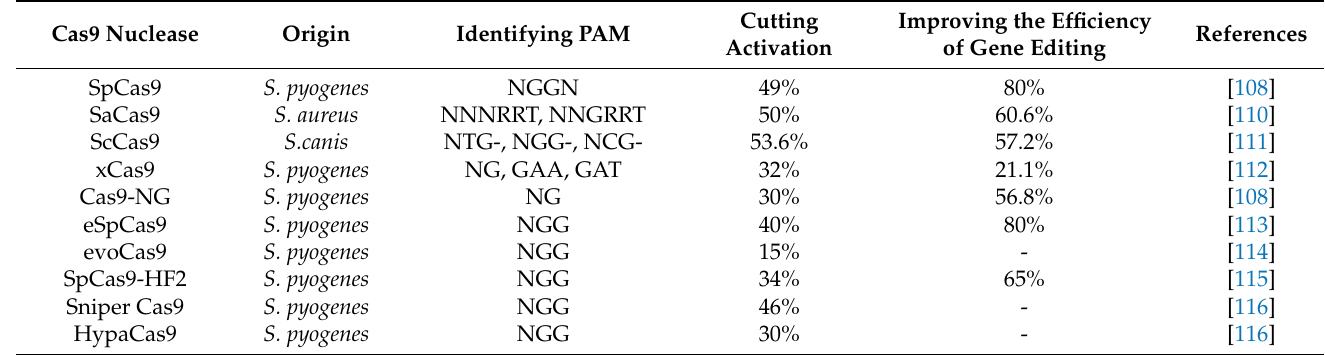
Table 1. Cas9 variant enzymes and the effects obtained in the plant